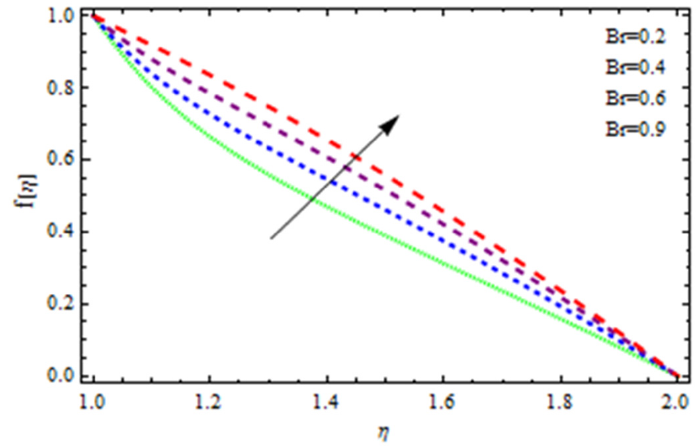
Figure 9. Influence of Br on the velocity curve in the case of Vogel’s model.